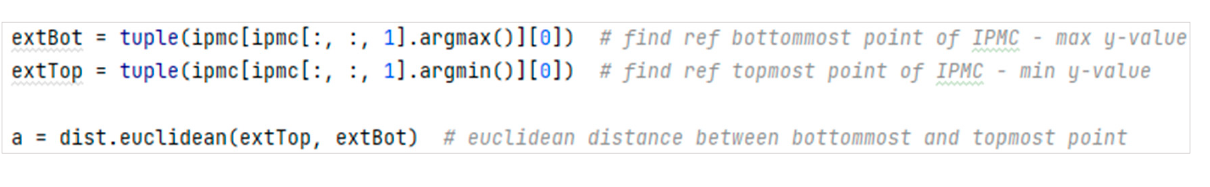
Figure 6. Calculating the Euclidean distance between points.